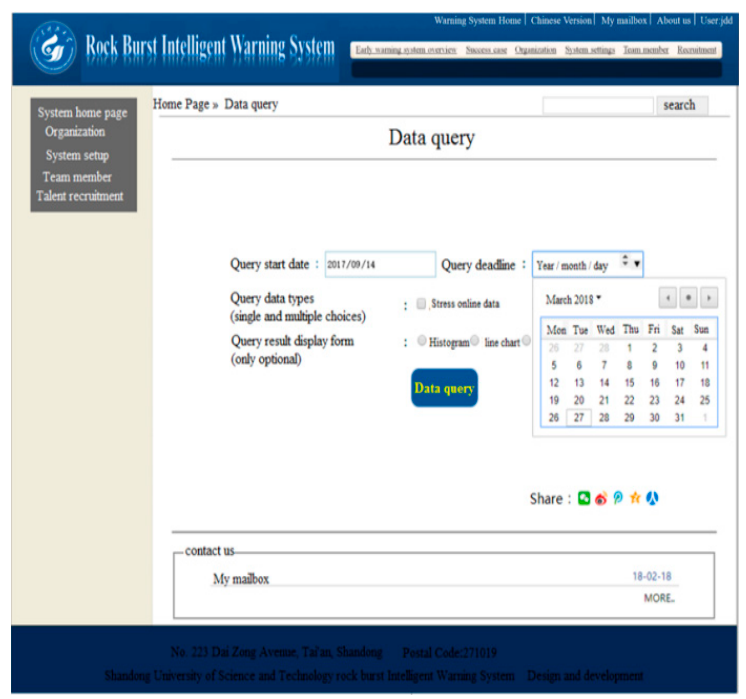
Figure 11. Data query result display page (fold line).